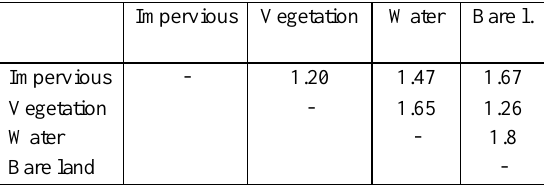
Table 3. Separability index for different pairs of land cover